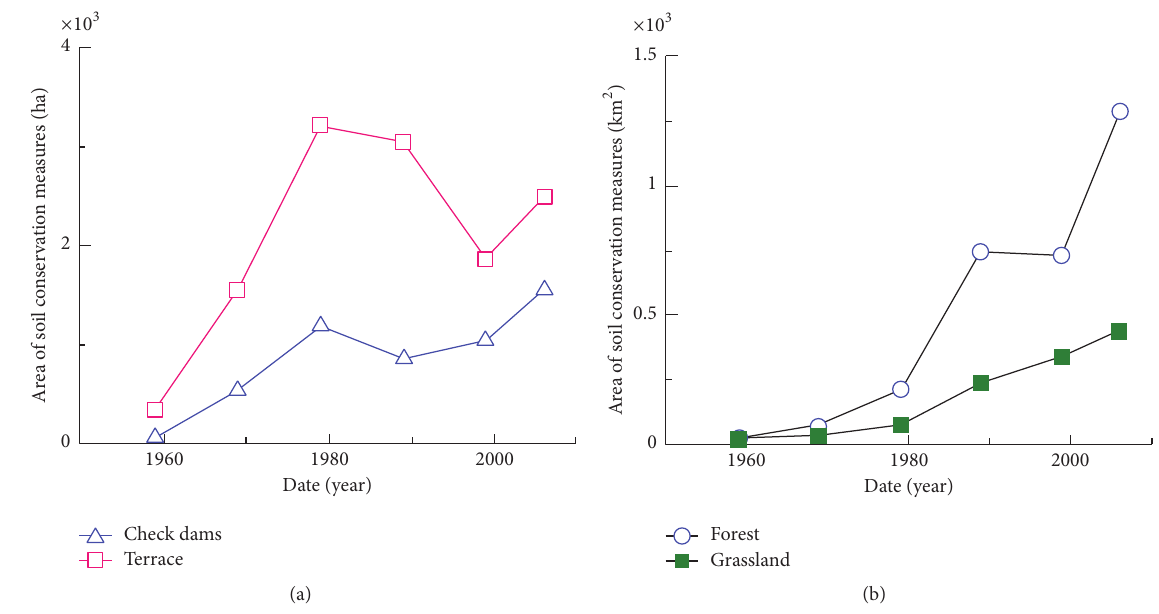
Figure 10: Statistics of soil and water conservation in the upstream Huangfu